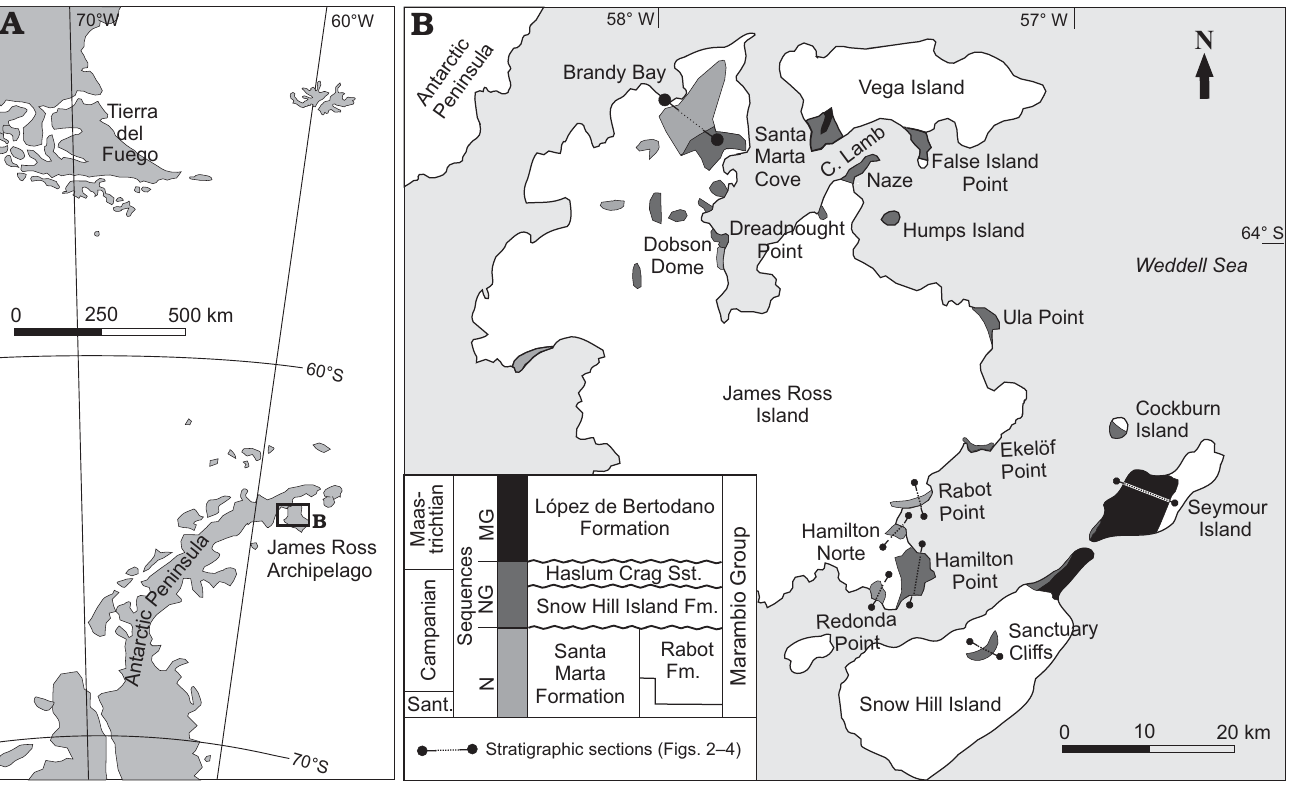
Fig. 1. Location map ( A ) and geological sketch ( B ) of the James Ross Basin, Antarctica. Abbreviations: C. Lamb, Cpe Lamb; Fm., Formation; MG, Maorites and Grossouvrites Sequence; N, Natalites Sequence; NG, Neograhamites and Gunnarites Sequence; Sant., Santonian; Sst.,